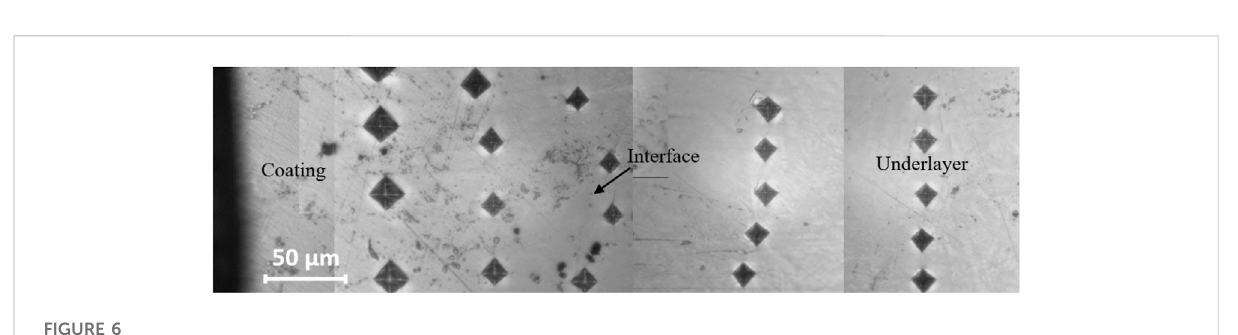
FIGURE 6 Stamped image of Vickers